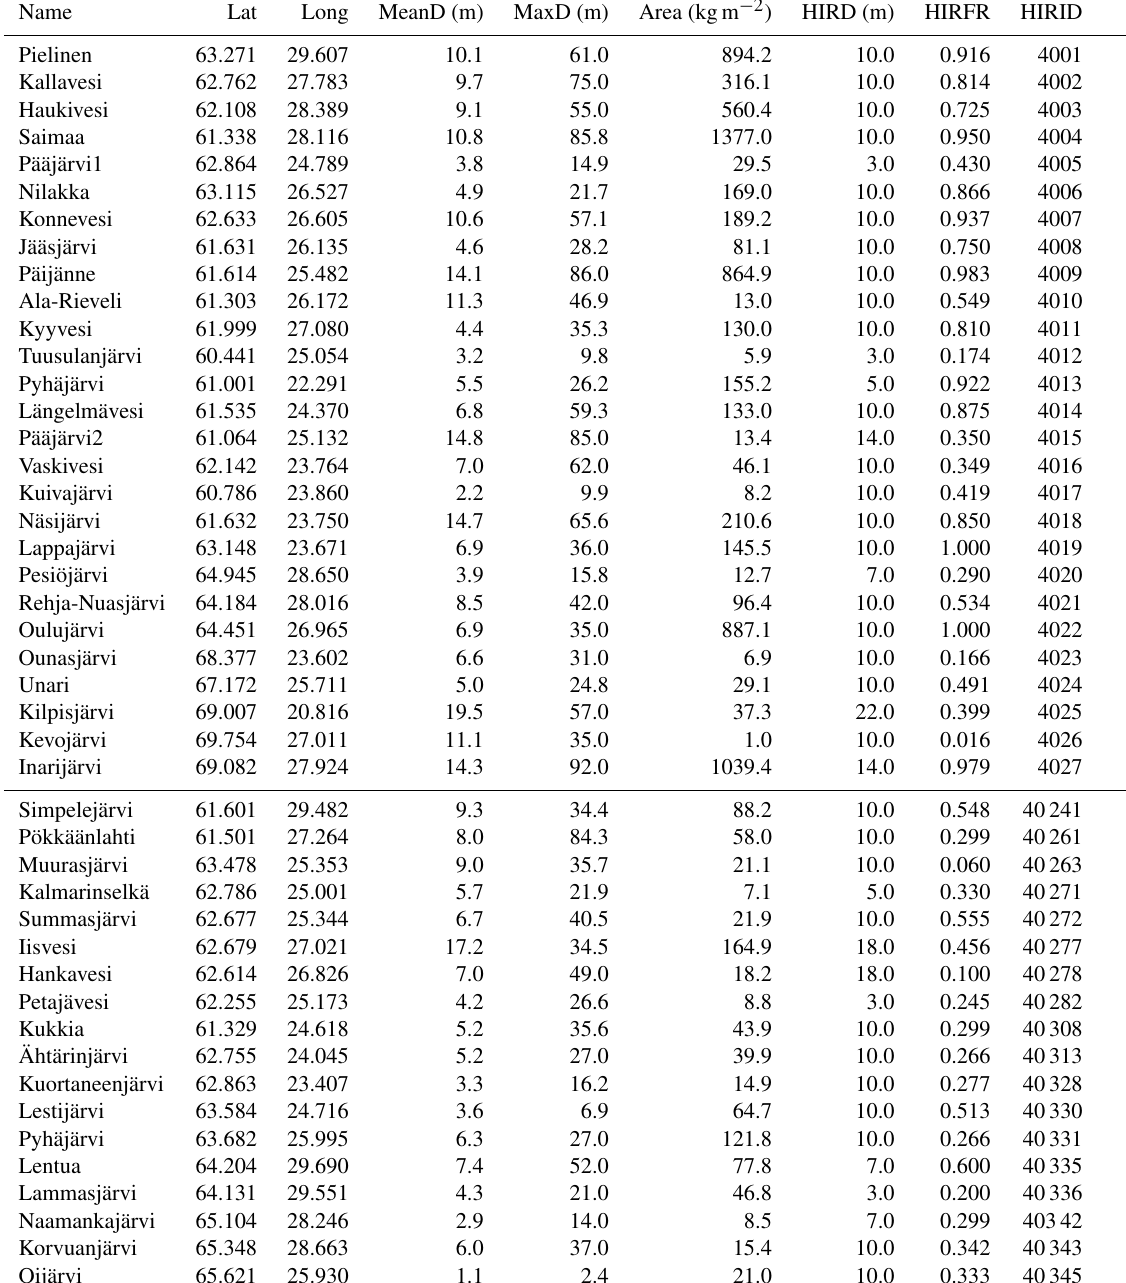
Table A2. Lakes with SYKE observations used in this